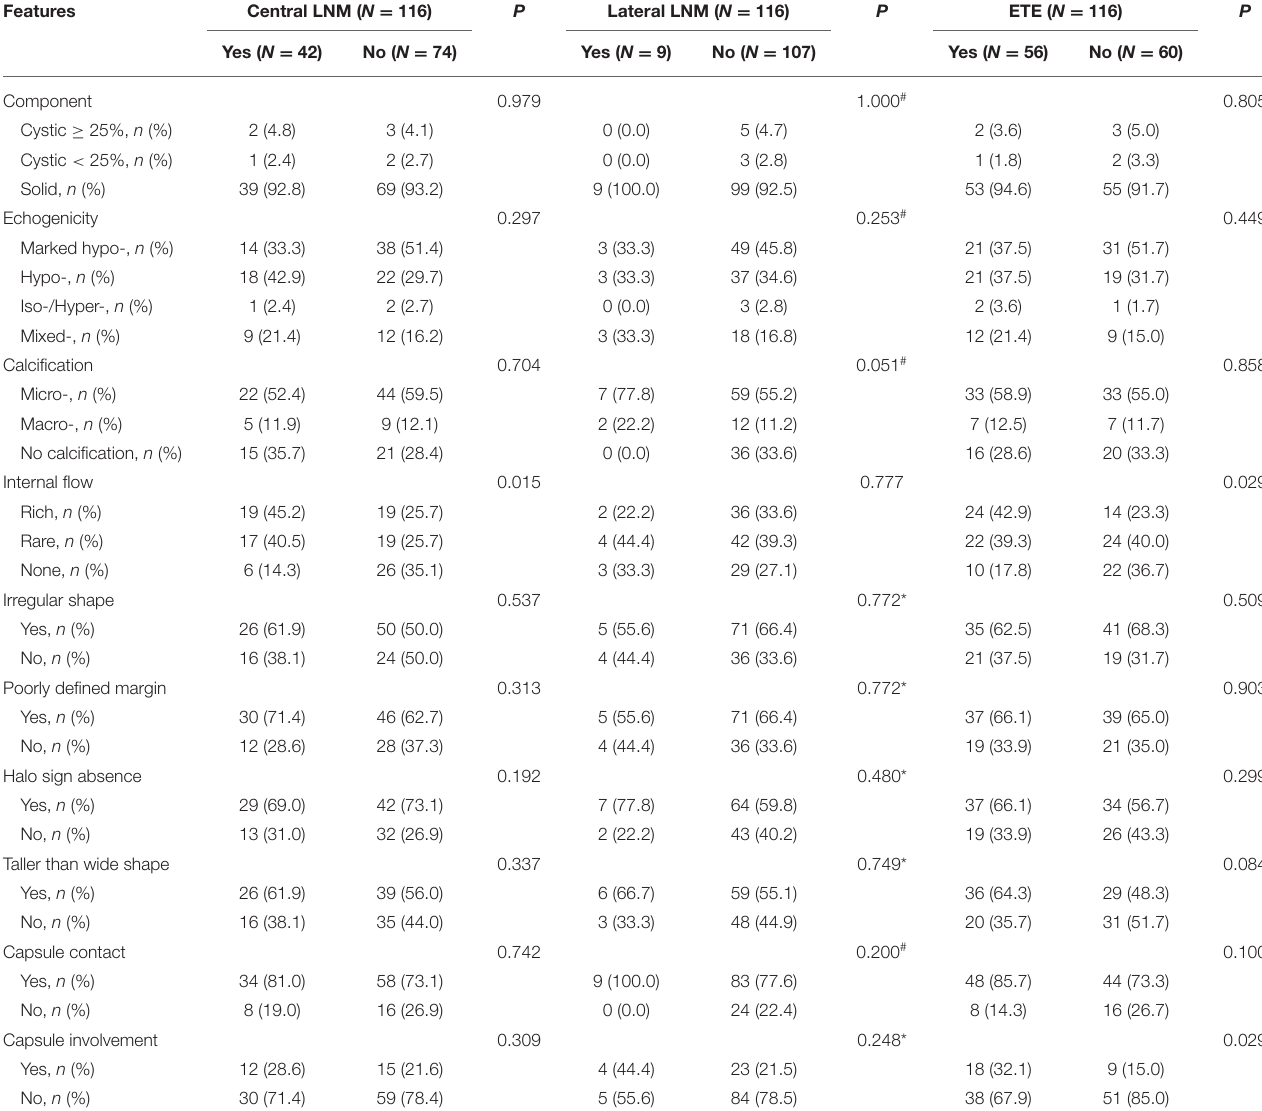
TABLE 2 | The US features of the papillary thyroid